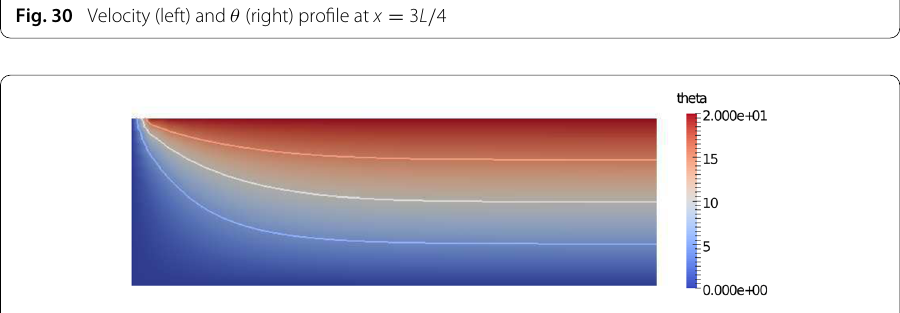
Fig. 31 Repartition of the passive